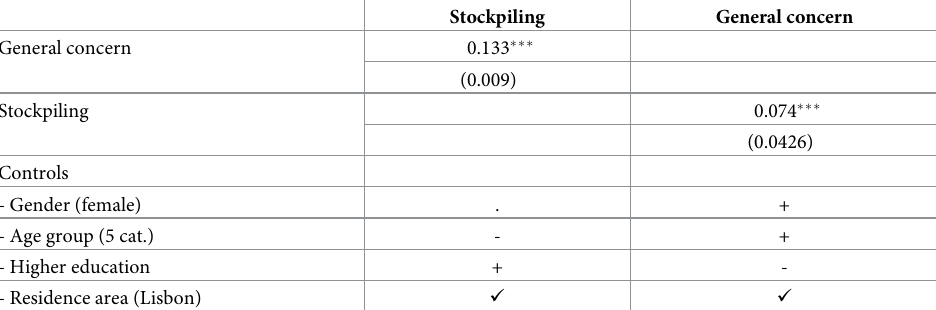
Table 6. Probit (margins) results for stockpiling and general concern with the